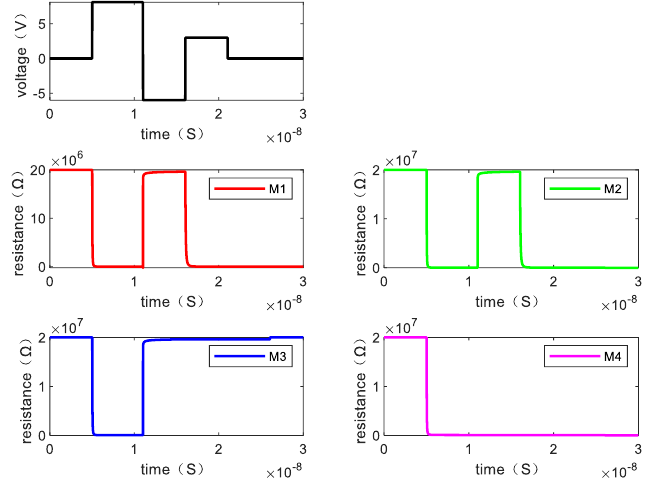
Figure 13. The changes of resistance value of each memristor when writing “1101”.